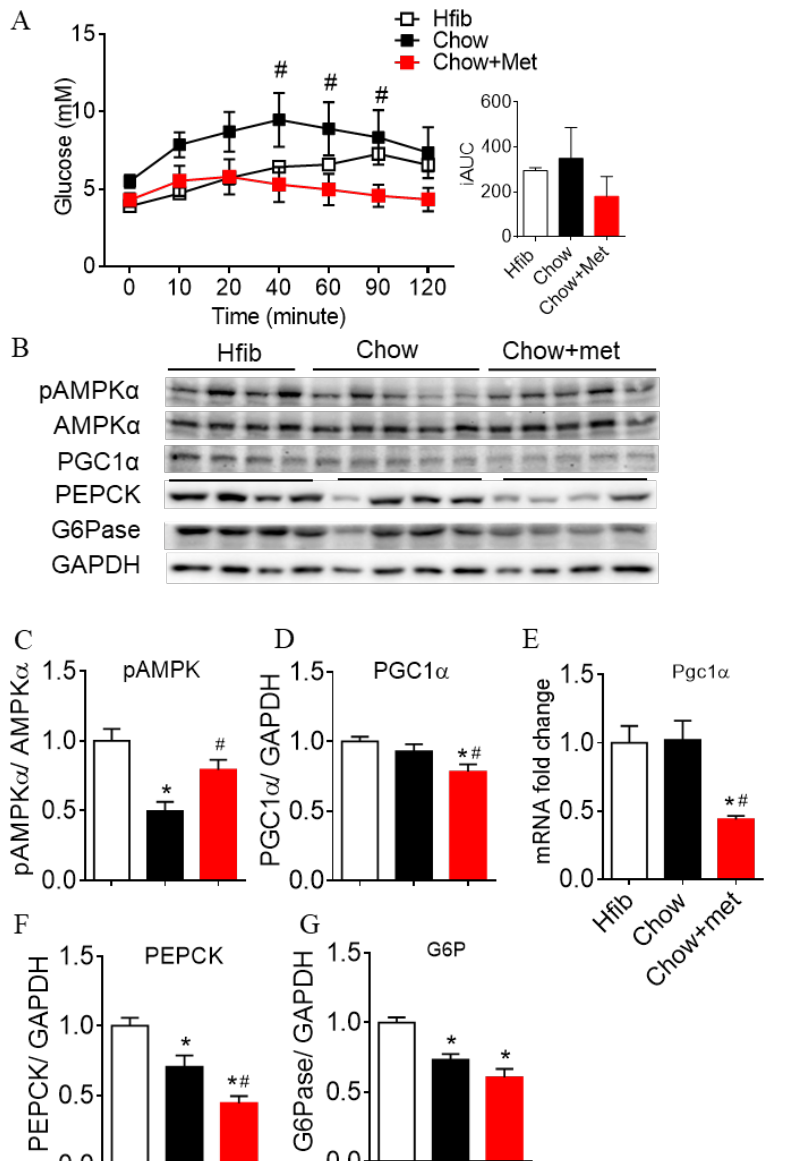
Figure 2. Metformin inhibited hepatic glucose production and glucogenic enzyme expression in the fed condition. ( A ): blood glucose and AUC in pyruvate tolerance test (PTT); ( B ): Representative images of liver protein; ( C , D , F , and G ): quantification of phospho-AMPK to AMPK ( C ), PCG1α ( D ), G6Pase ( F ), and PEPCK ( G ) relative to GAPDH; ( E ): gene transcription of PGC1α normalized to β-actin. Data are presented as mean + SEM. n = 4–6. * indicates p < 0.05 vs. Hfib, # p < 0.05 vs. Chow using the Kruskal–Wallis test followed by Dunn’s multiple comparison test.